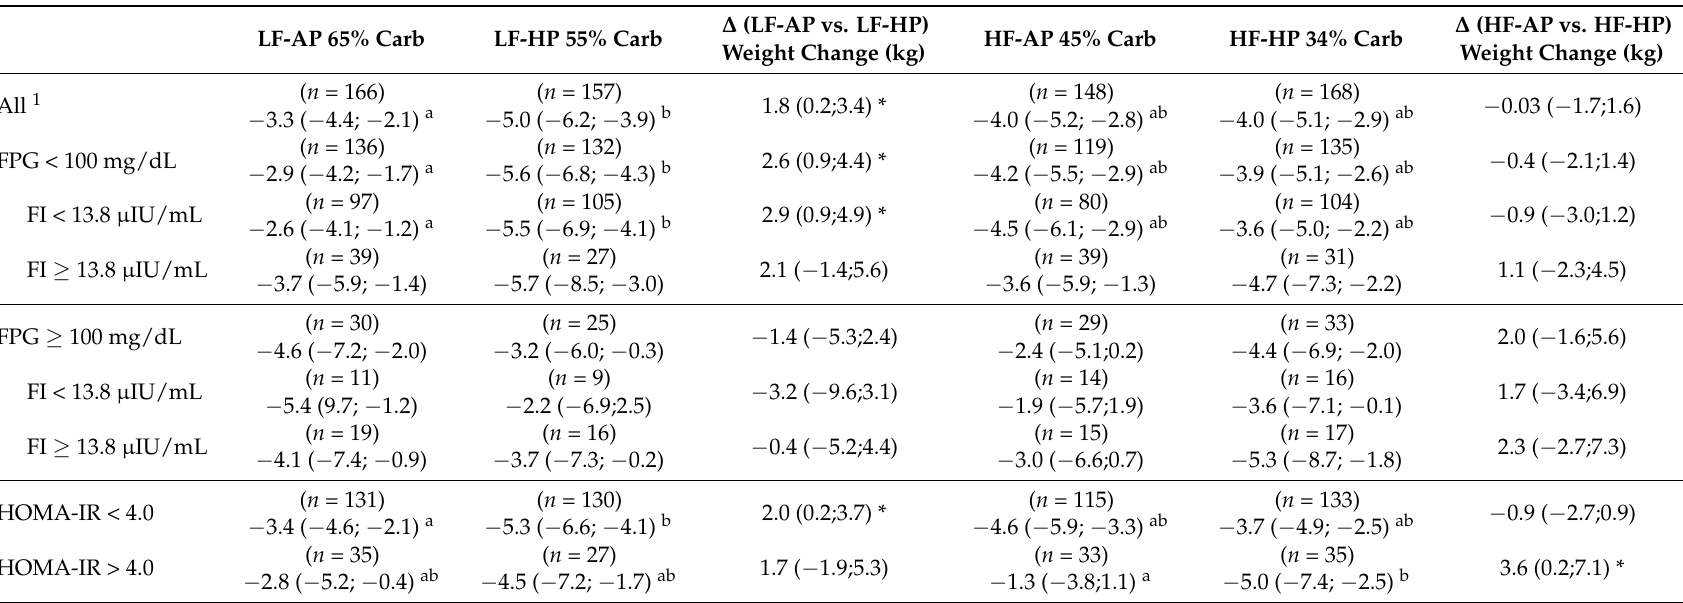
Table 2. Two-year weight change according to randomization and stratified on pretreatment FPG and FI ( n =